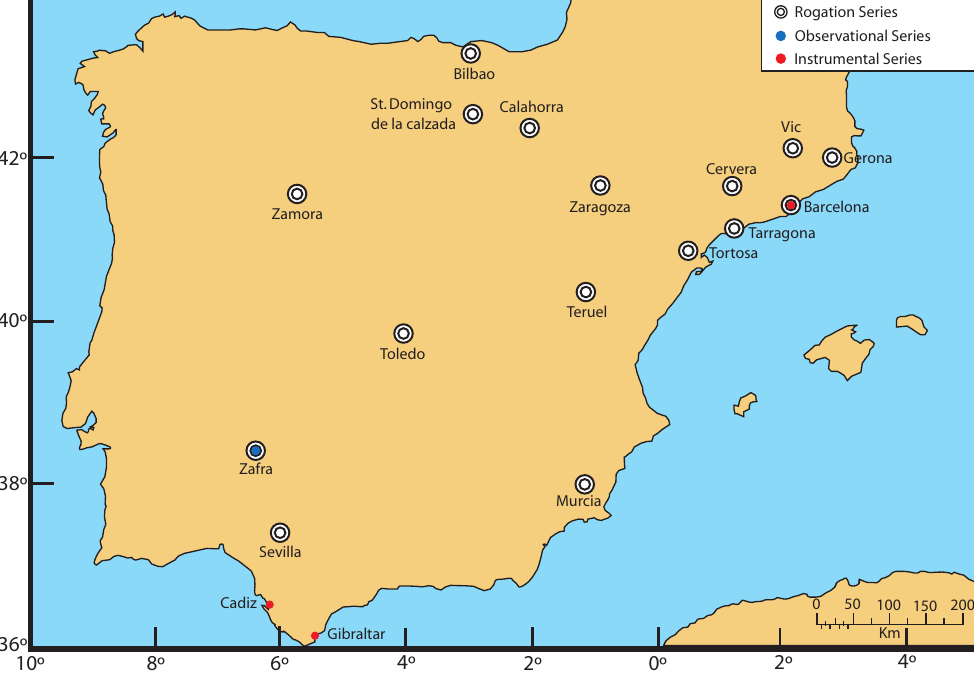
Fig. 1. Location of the rogation observational and instrumental